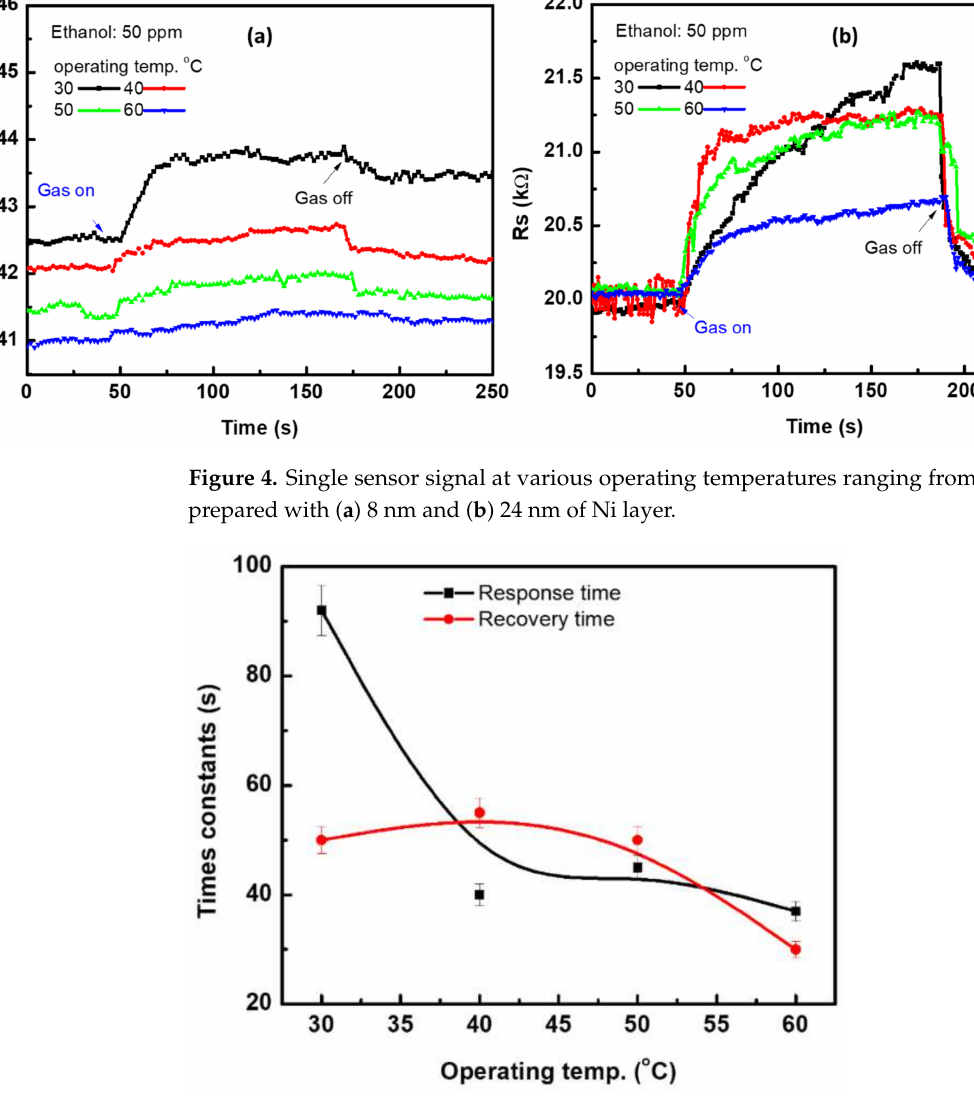
Figure 5. Response and recovery time constants at various operating temperatures for CNTs prepared with 24 nm of Ni